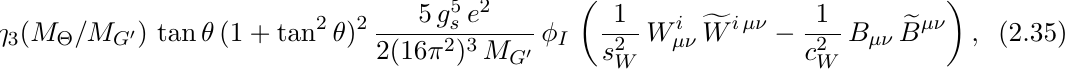
Figure 4 . Additional decays of the two loops. Right diagram: (cid:30) I